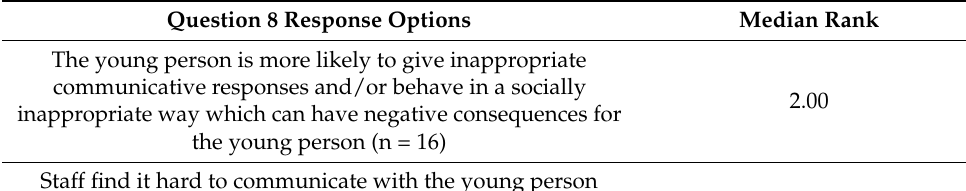
Table 7. Survey: Question 8. If yes, please rank the following reasons from 1–5, where 1 represents the most common reason and 5, the least common reason (n = 16/23